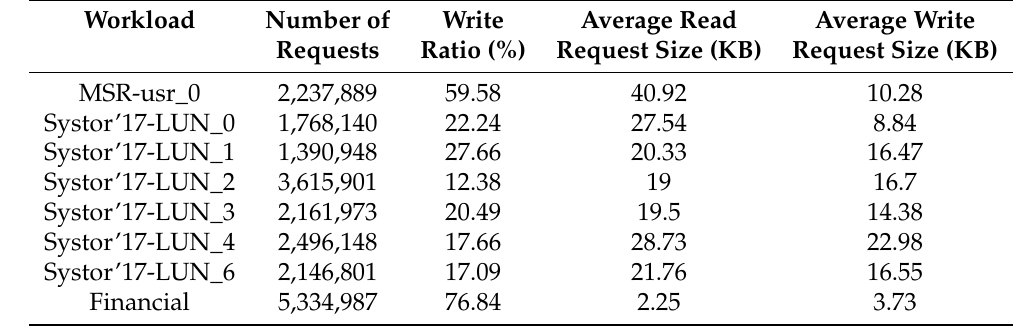
Table 2. Characteristics of 8 workload